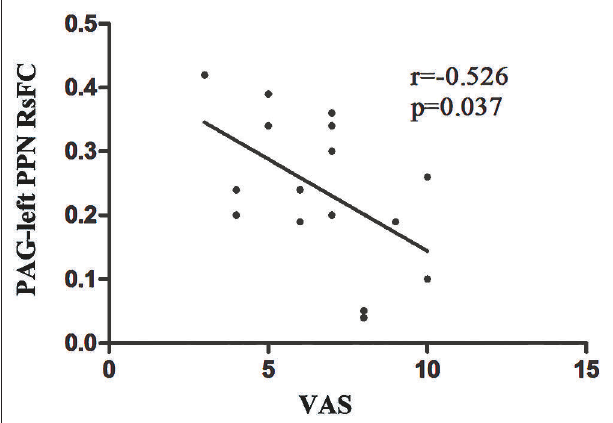
FIGURE 3 | The relationship between PAG-left PPN RsFC and VAS scores.